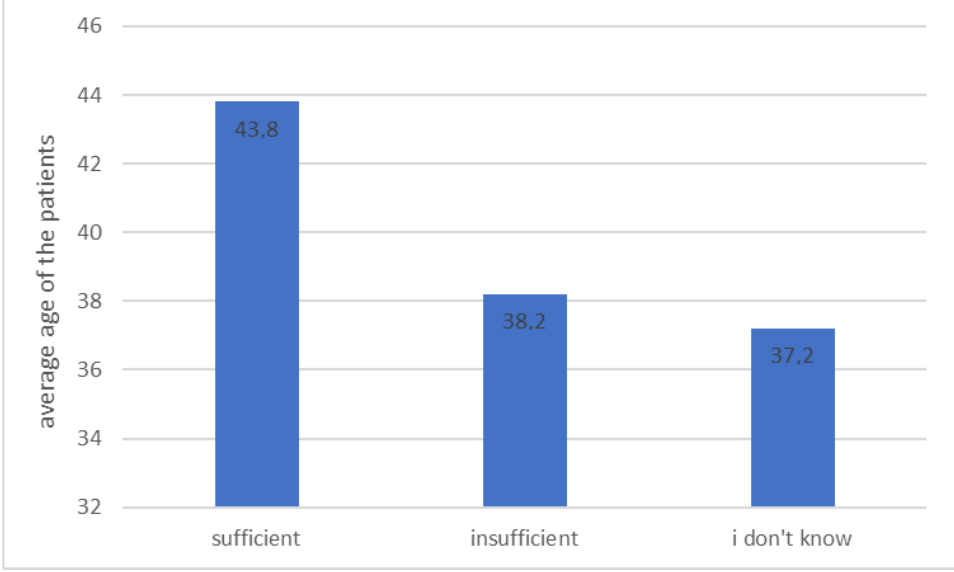
Figure 4. Average age of patients depending on their self-assessment of knowledge about diabetes ( n = 131, p < 0.001).